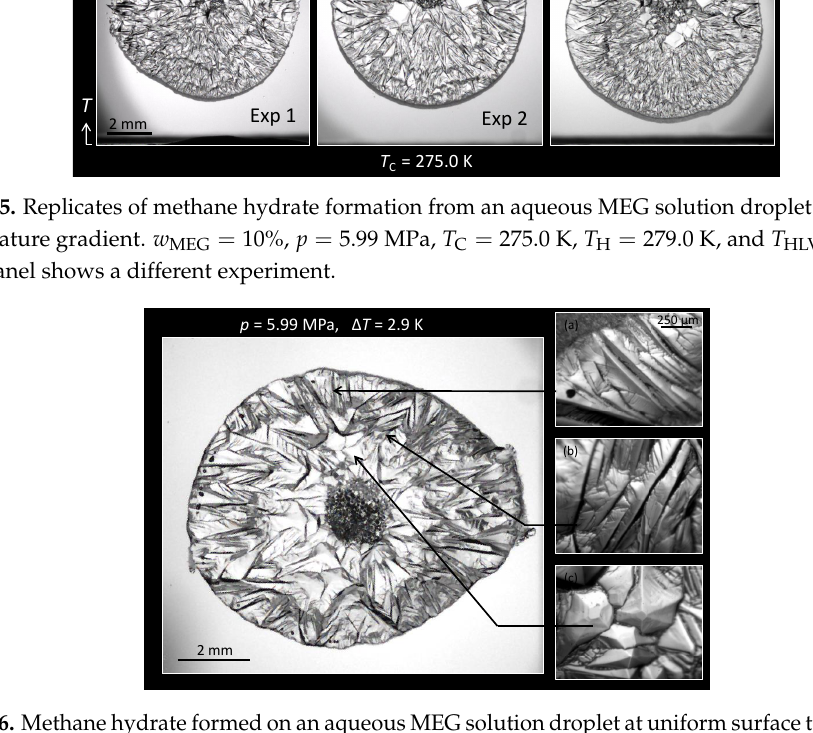
Figure 6. Methane hydrate formed on an aqueous MEG solution droplet at uniform surface temperature. w MEG = 10%, p = 5.99 MPa, T = 276.8 K ( ∆ T sub = 2.9 K). ( a ) Halo propagation from the droplet boundary. ( b ) Crystal growth inside the droplet boundary, but far from initial growth points. ( c ) Individual crystal geometry grown from initial growth